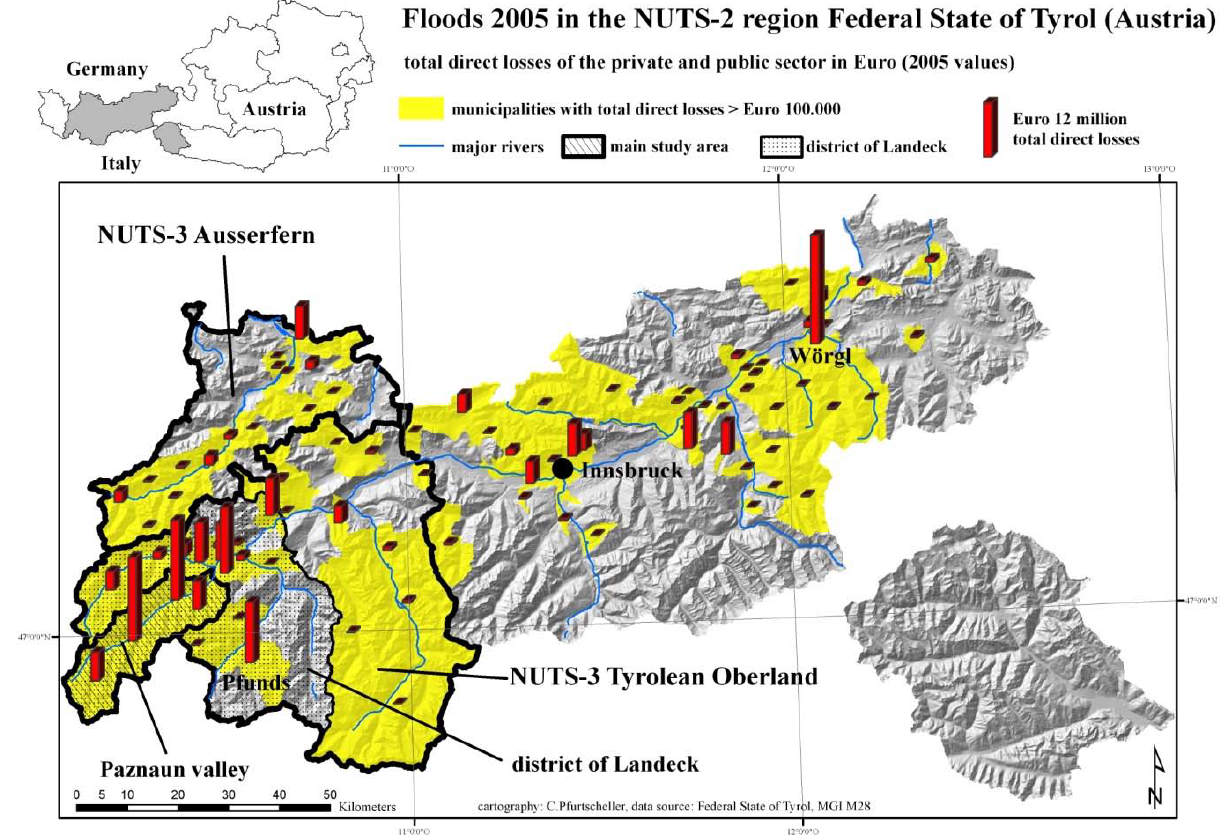
Fig. 1. Cartographical overview of recorded total direct losses >100000 Euros in the public (municipality and federal assets) and private sectors (households, businesses) at the municipal level, the assessed NUTS-3 regions, the main study area, and the most affected munici- palities in the Federal State of Tyrol (Austria); Data source: Federal State of Tyrol (Austrian Disaster Fund / department for rural areas and agriculture, department for roads and traffic, department for municipal affairs). Table 1. Main socio-economic facts of the study areas at different levels of aggregation; source: Statistics Austria, Federal State of Tyrol. Paznaun District NUTS-3 region NUTS-2 region valley of Landeck Tyrolean Oberland Federal State of